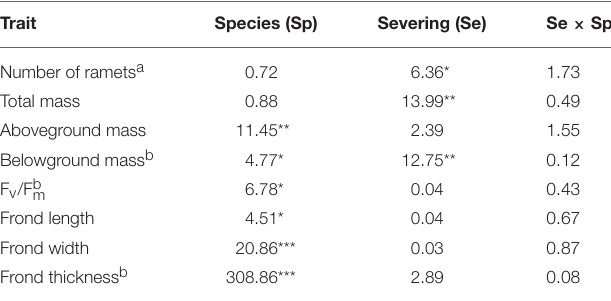
TABLE 3 | Group experiment results of a two-way ANOVA for effects of species and rhizome severing on the number of ramets, biomass, F v /F m , and frond